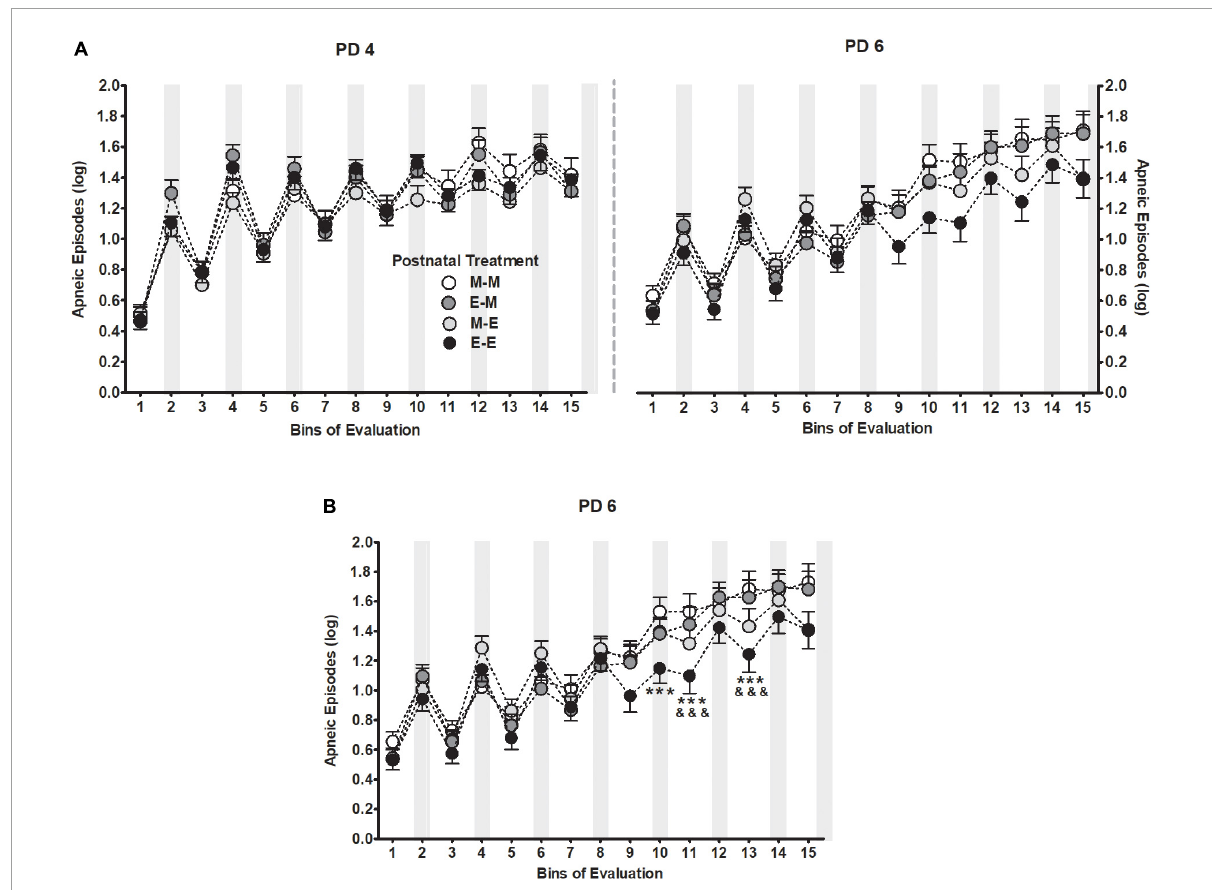
FIGURE3 Apneic episodes (log) [bij = log (apneic episode + 1)] as a function of postnatal treatment across bins of evaluation (A) during PDs 4 and 6 (B) and at PD6. Gray bars indicate intraoral infusions during the artificial lactation test. Black dots represent pups that received ethanol as the sole liquid (E-E) both days, dark gray dots represent pups exposed to milk mixed with ethanol at PD4 and switched to milk as the sole liquid at PD6 (E-M), light gray dots represent pups initially exposed to milk and switched to milk mixed with ethanol at PD6 (M-E), white dots represent pups that received milk as the sole liquid (M-M) both days. Differences at PD6 between E-E and M-M groups (*** p < 0.001), and between E-E and E-M groups ( &&& p < 0.001) within a time point. Vertical lines illustrate standard errors of the mean